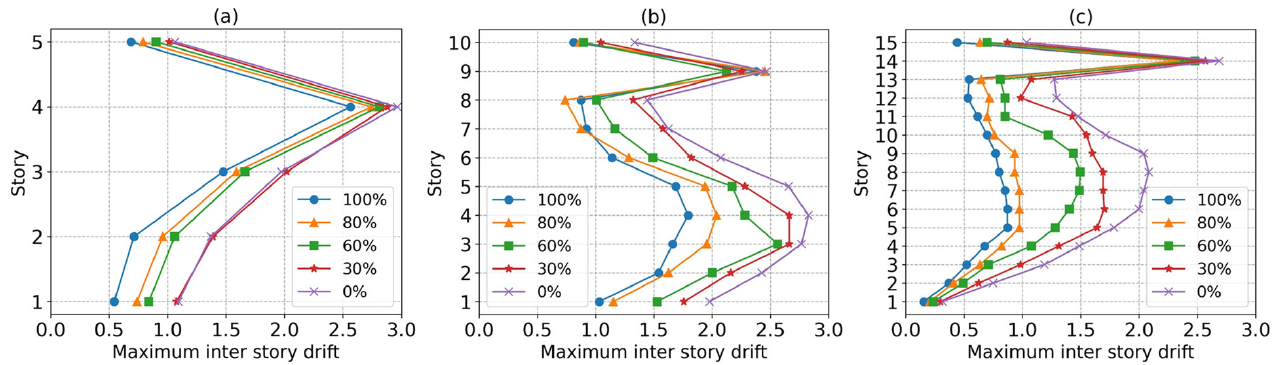
Figure 17. Maximum inter-story drift: ( a ) 5 stories; ( b ) 10 stories; and ( c ) 15 stories. By decreasing the rigidity of the five-story frames including SPSWs with 200 mm circular holes implemented in them, the residual displacement of different frames was